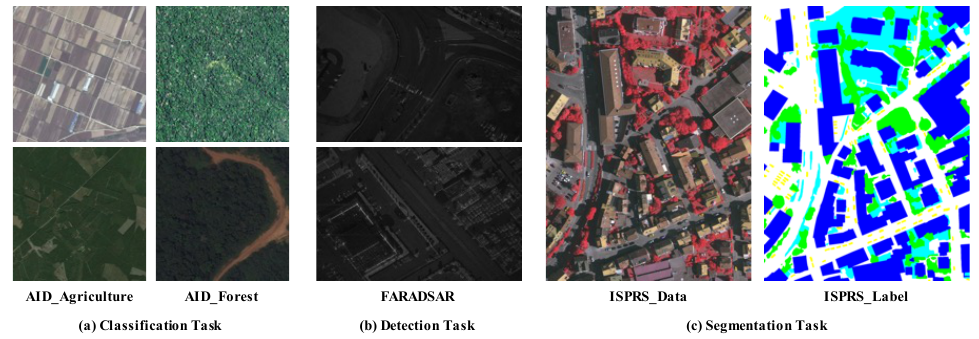
Figure 2. Some samples of unsupervised domain adaptation based on remote sensing data. ( a ) Samples of the classification task based on the optical AID datasets. ( b ) Samples of the detection task based on the FARADSAR dataset. ( c ) Samples datasets of segmentation task, which are the data and labels of ISPRS Vaihingen,